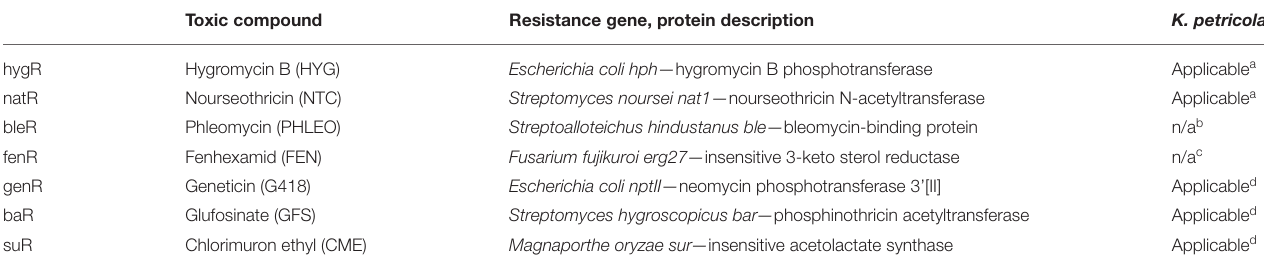
TABLE 1 | Five resistance selection marker systems are available for K. petricola